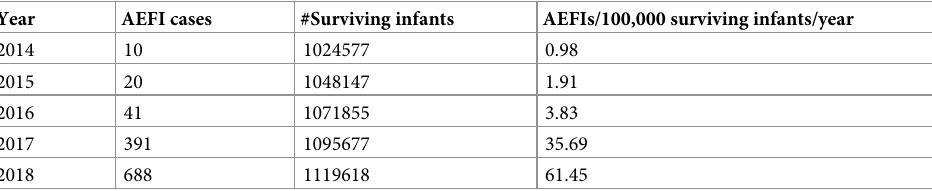
Table 2. Annual performance on AEFI reporting in Ghana,